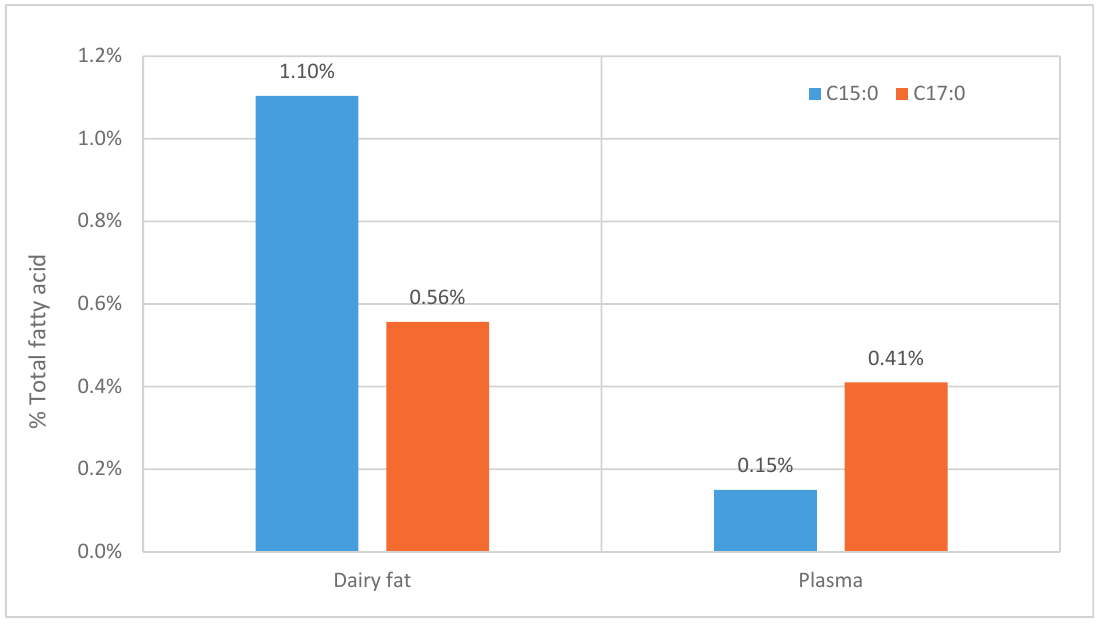
Figure 4. The comparison between the C15:0 and C17:0 fatty acids within dairy products [4] and the comparative concentration within in plasma